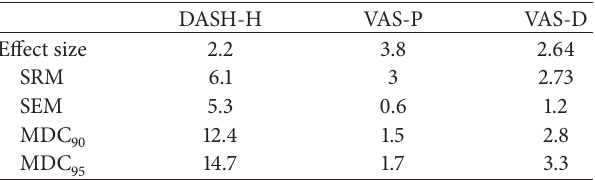
Table 4: Responsiveness and other statistics between occasion 1 and occasion 3 ( 𝑁 =